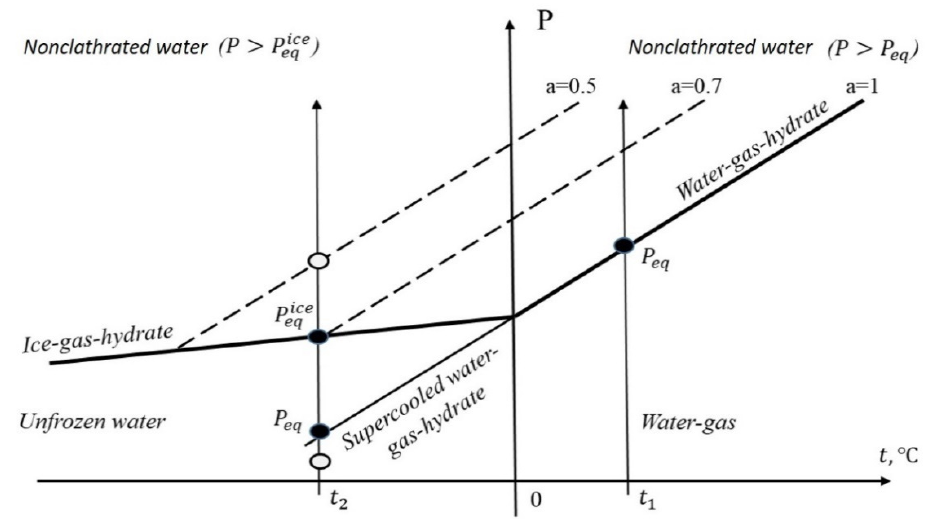
Figure 1. Unfrozen and nonclathrated water P-T conditions in porous media. Bold lines: three-phase gas–ice or supercooled water–hydrate equilibrium line; dotted lines: three-phase gas–water–hydrate equilibrium line at given pore-water activity.